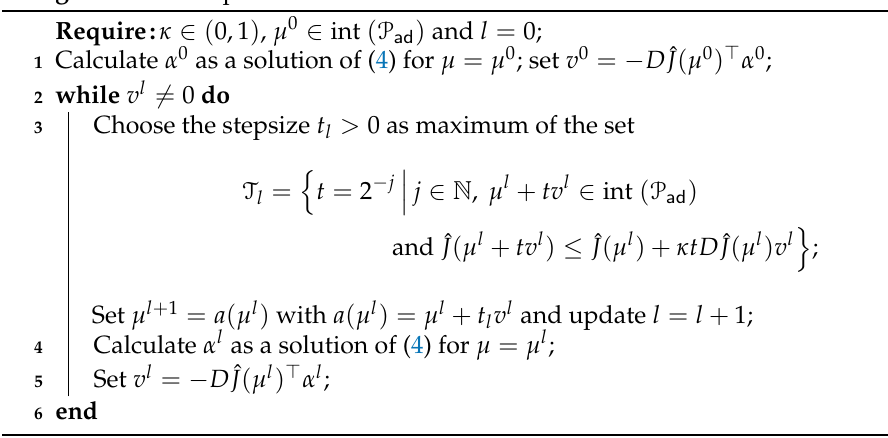
Algorithm 1: Steepest descent